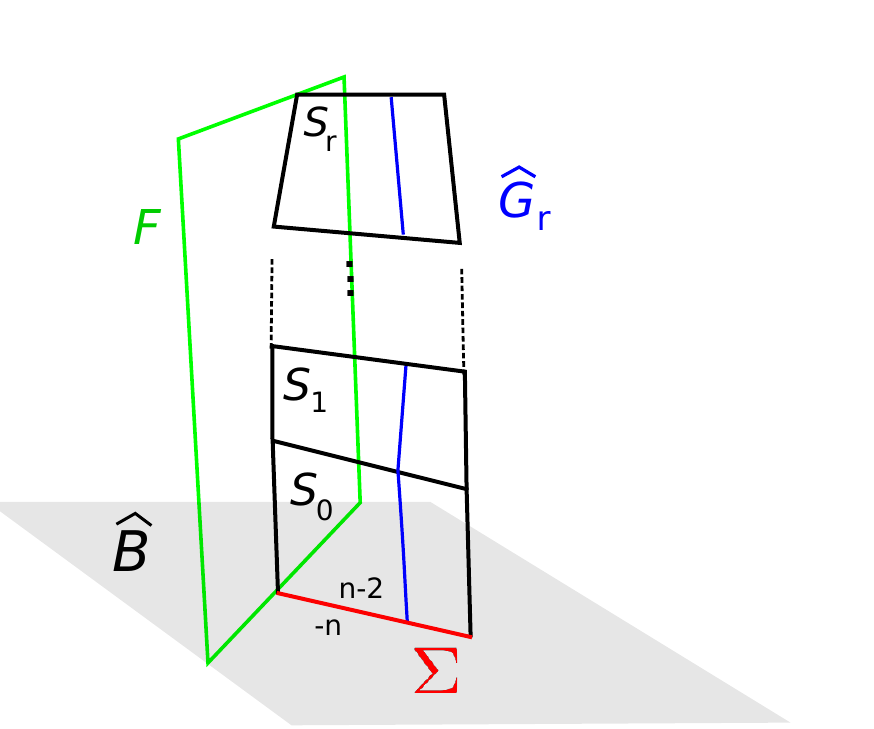
Figure 16. Schematic description of the generic geometry for rank-one